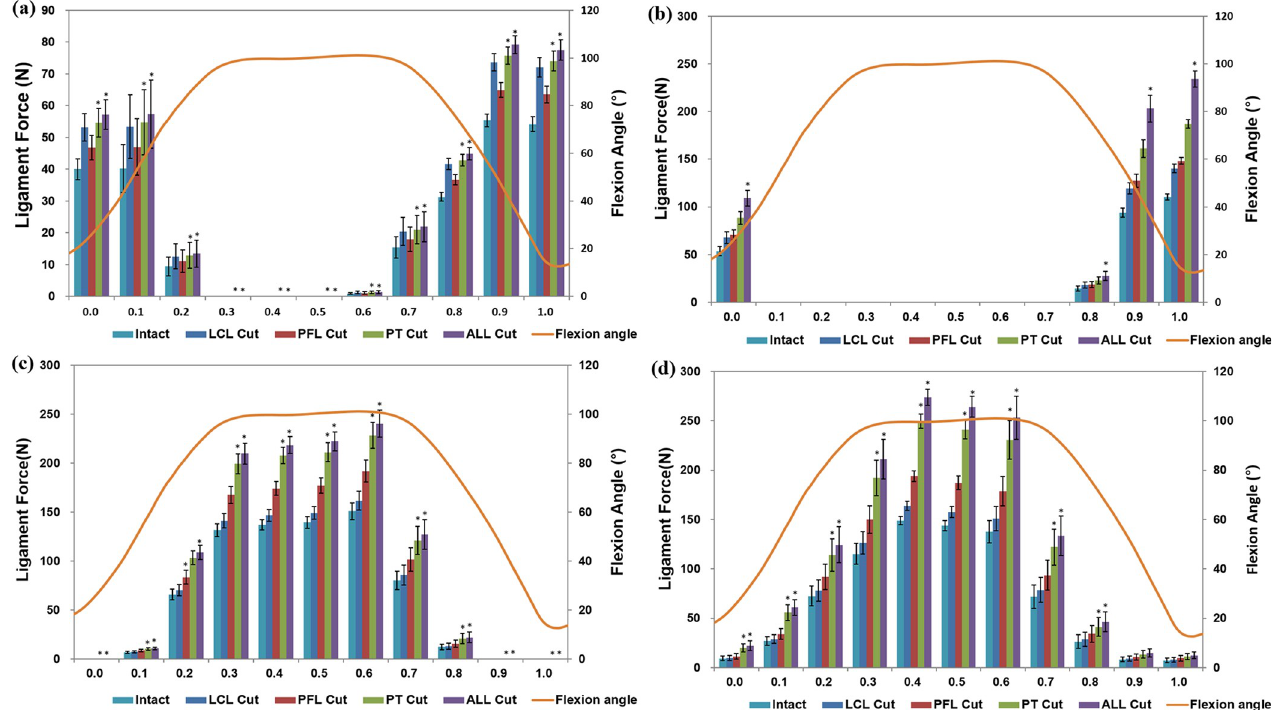
Fig 6. Mean ( ± SE) force exerted on the (a) aACL, (b) pACL, (c) aPCL, and (d) pPCL with deficiencies of the LCL, PFL, PT, and PLC structures under the squat loading condition ( � P < .05).